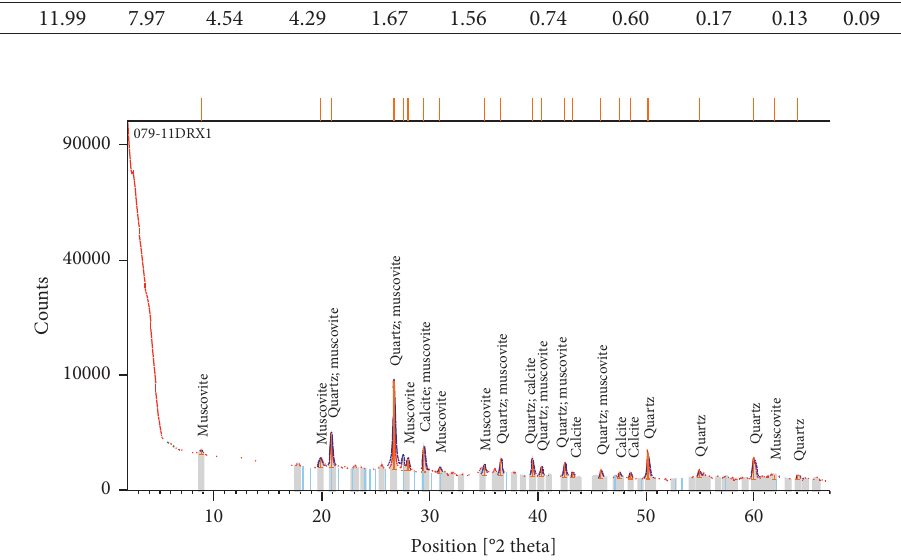
Figure 2: X-ray diffraction spectrum of Sale clay.